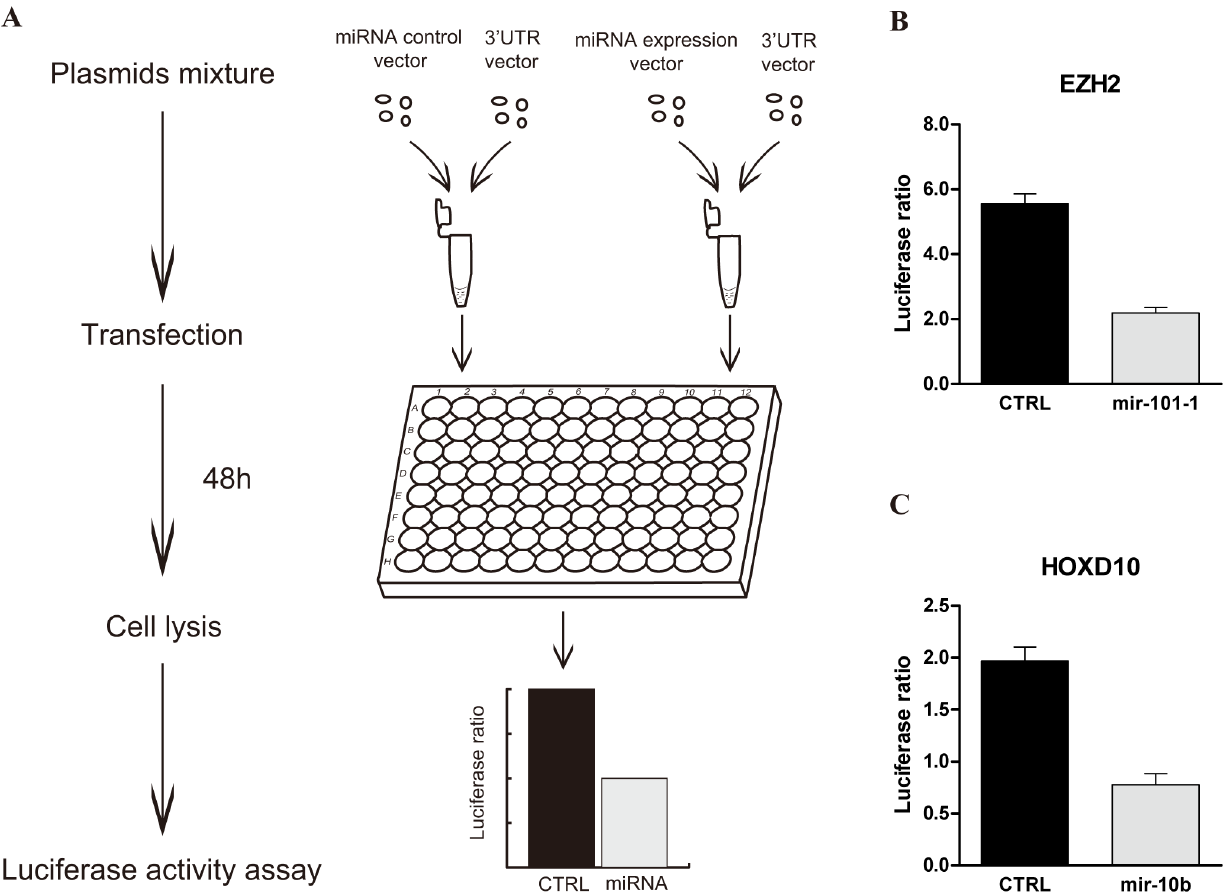
Figure 2. The strategy for validation of the interactions between miRNAs and target gene 3 9 UTRs. (A) The experiment procedures. (B) and (C) Co-transfection of pre-miRNA (0.15 m g) and the luciferase reporter containing the target gene 3 9 UTR (0.05 m g) into 293T cells to test the reported interactions of miR-101-3p and EZH2 3 9 UTR (B) or miR-10b-5p and HoxD10 3 9 UTR (C), with co-transfection of the empty vector of pre-miRNA and the luciferase reporter containing the same 3 9 UTR as the control. The data were normalized to the ratio of Renilla and firefly luciferase activities measured at 48 h post transfection. Values represent the mean 6 S.D. from three independent transfection experiments.